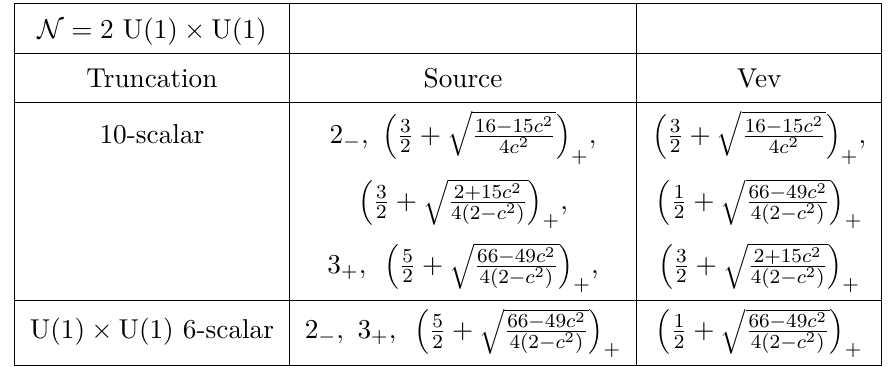
Table 4 . BPS modes for the one-parameter family of N = 2 U(1) × U(1) invariant S-folds, where c = cos(2 φ 1 ) .